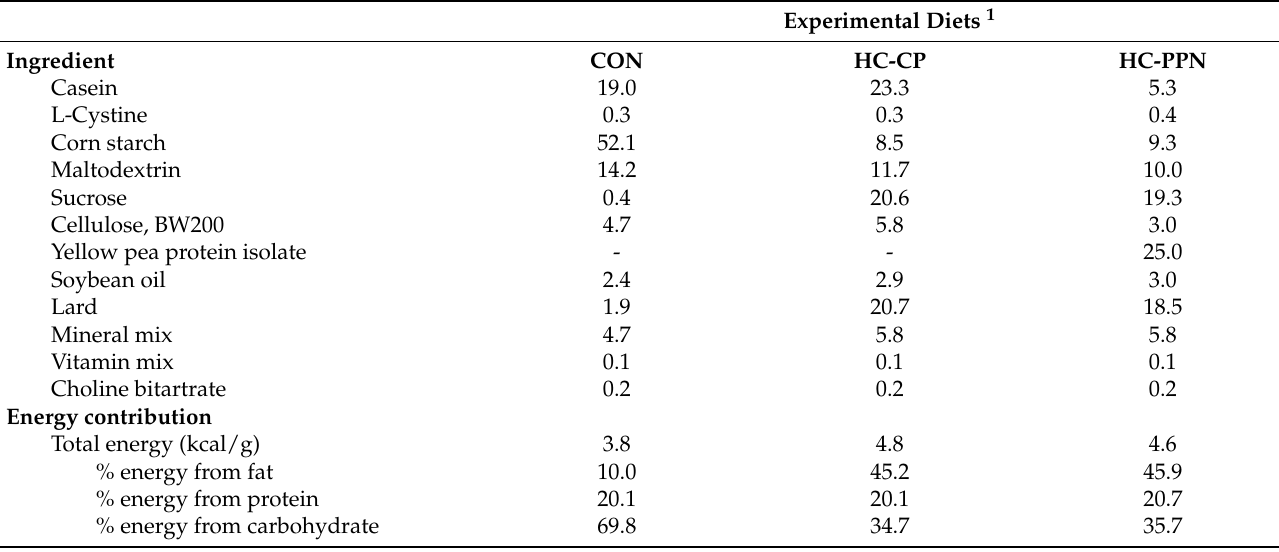
Table 1. Experimental diet formulation (% composition).